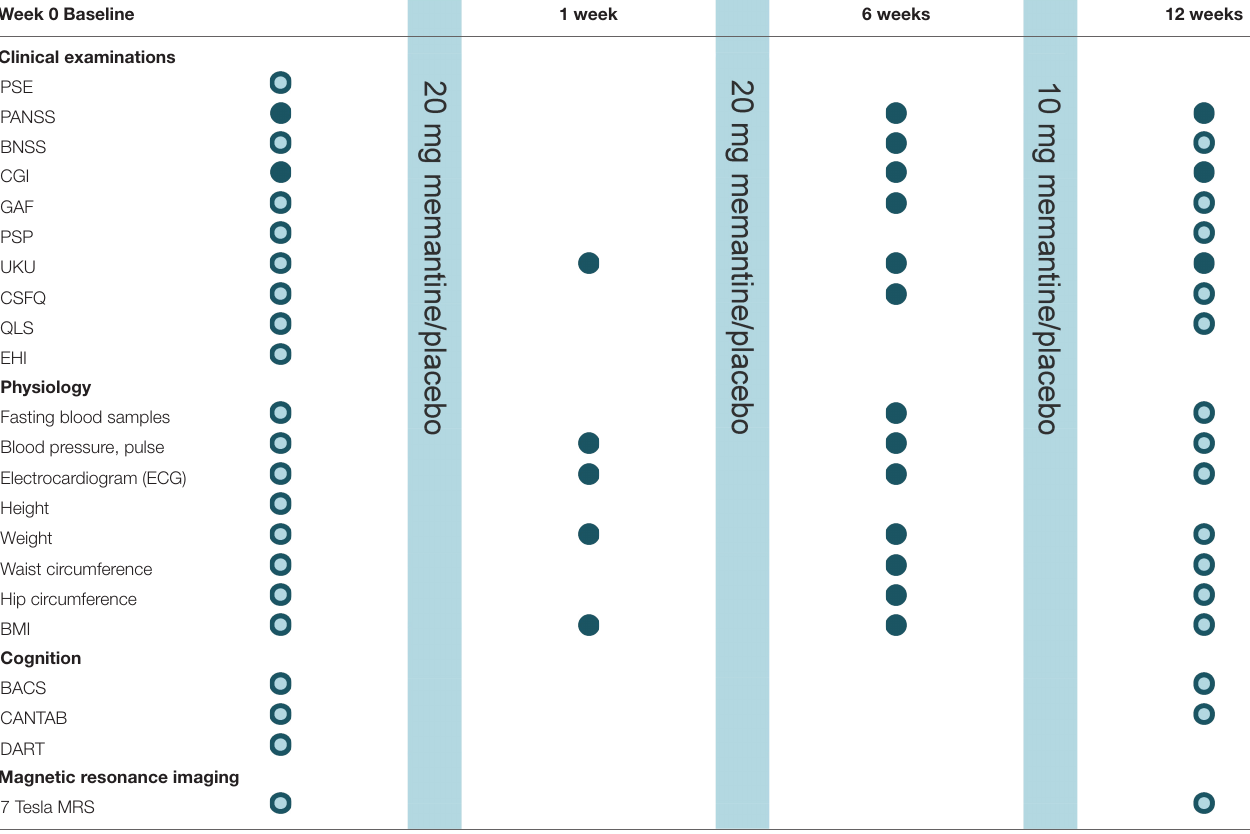
TABLE 2 | AMEND examination